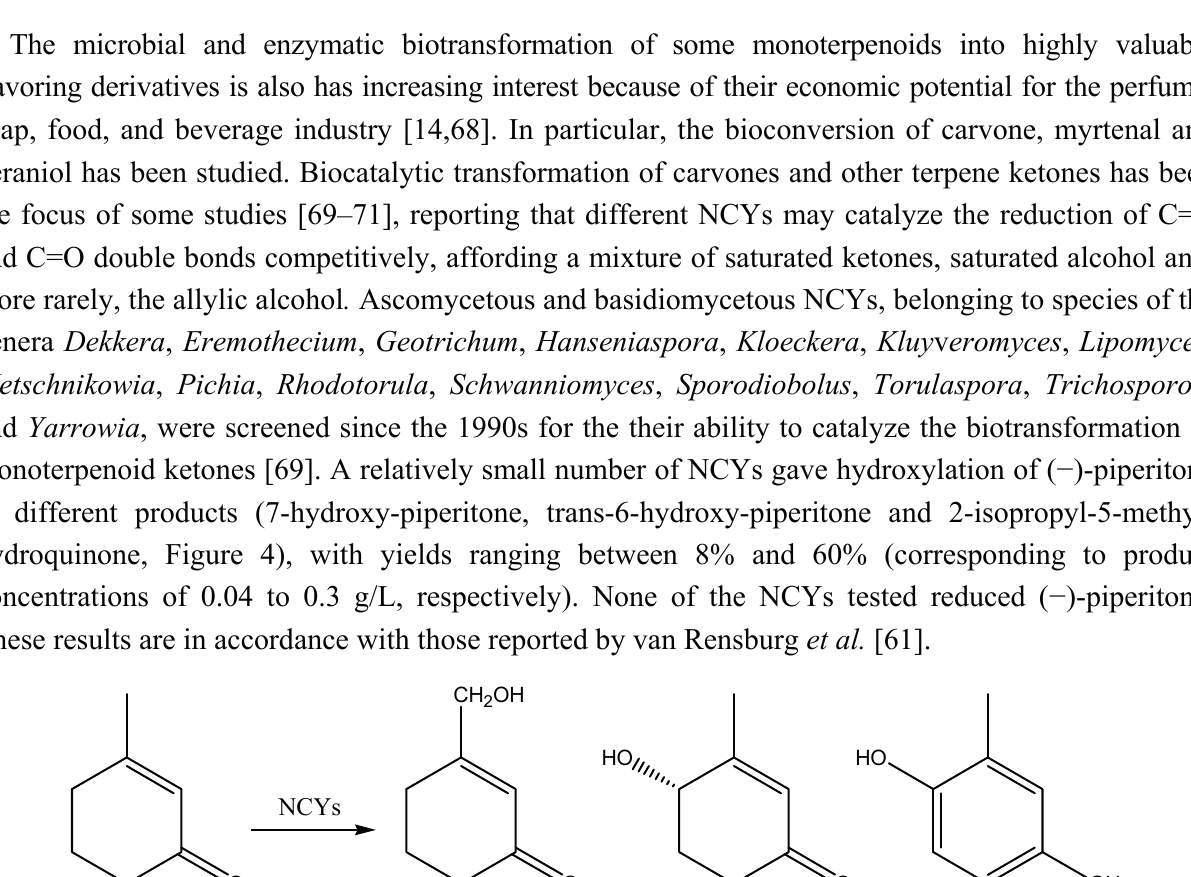
Figure 3. Biotransformation of ( − )-( R )- α -phellandrene to 5- p -Menthene-1,2-diol promoted by Y. lipolytica .